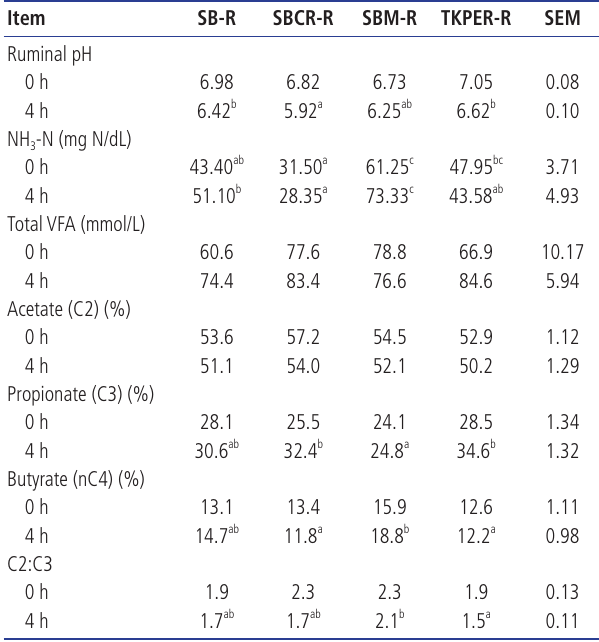
Table 4. Ruminal fermentation in wethers fed with the experimental diets at 0 and 4 h after